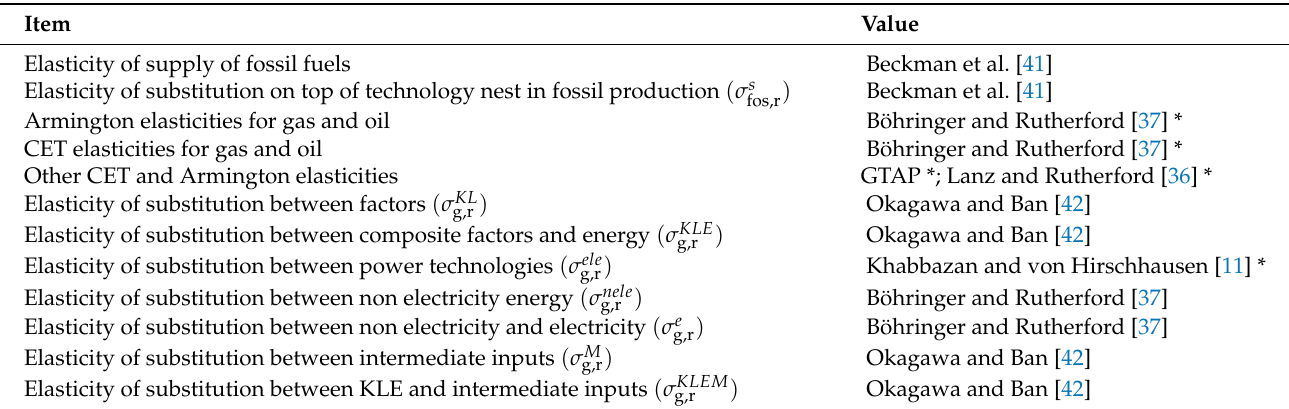
Figure 2. Nesting structure in fossil fuel production [11]. Table 1. Main elasticity